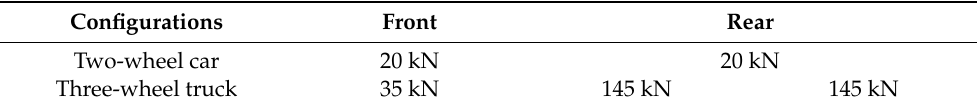
Table 1. Configurations of the moving load in the simulation. Configurations